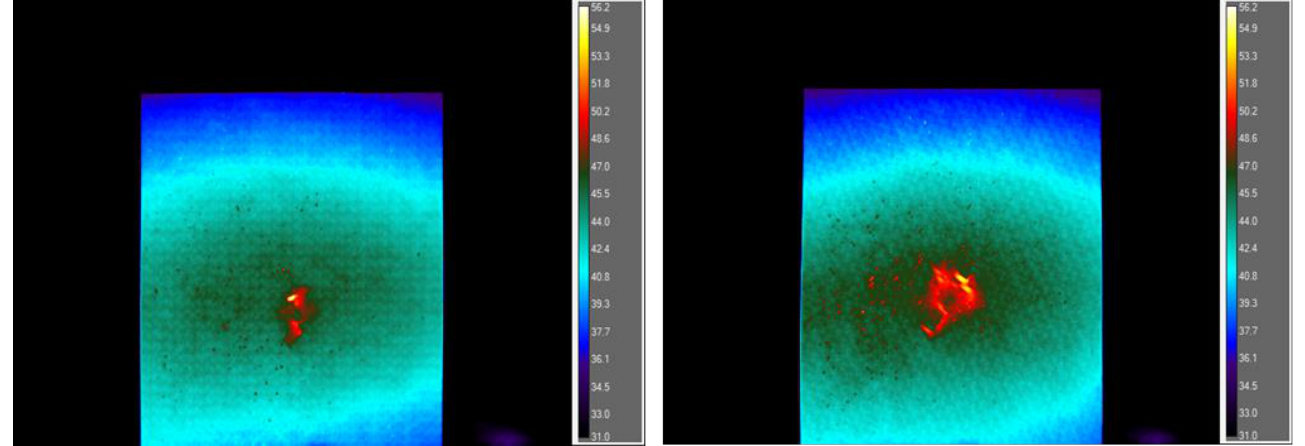
Figure 16. IR thermography of damaged initial 3R laminates at 9 J ( left ) and 15 J ( right ).